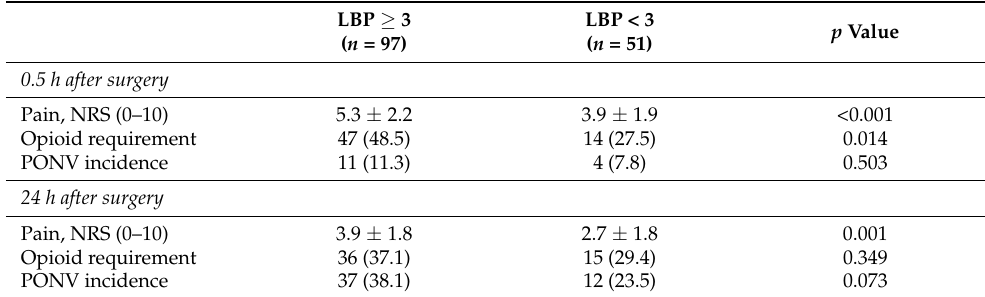
Table 3. Postoperative data in patients dichotomized for preoperative lower back pain intensity. Values are as means ± SD or number (%).